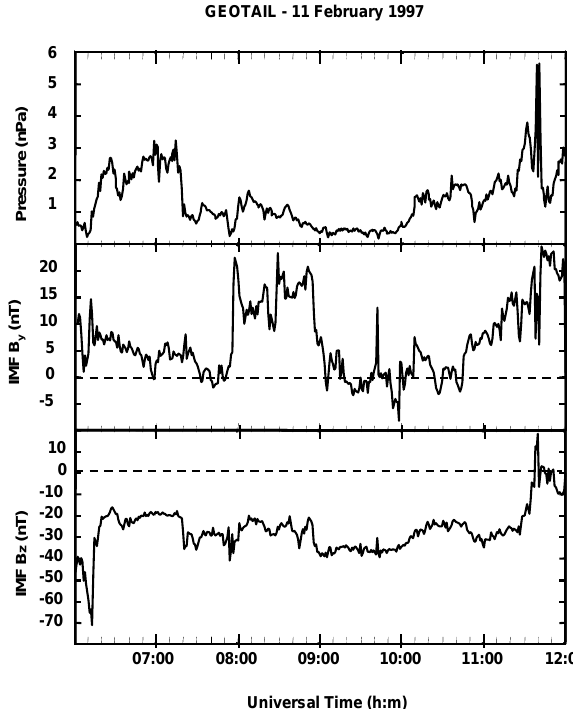
Fig. 2. Solar Wind data taken from the GEOTAIL spacecraft. The satellite was crossing the front of the magnetopause at 10 R E for the duration of this event. The panels illustrate (bottom to top): predominantly negative IMF B z , positive IMF B y and the low solar wind dynamic